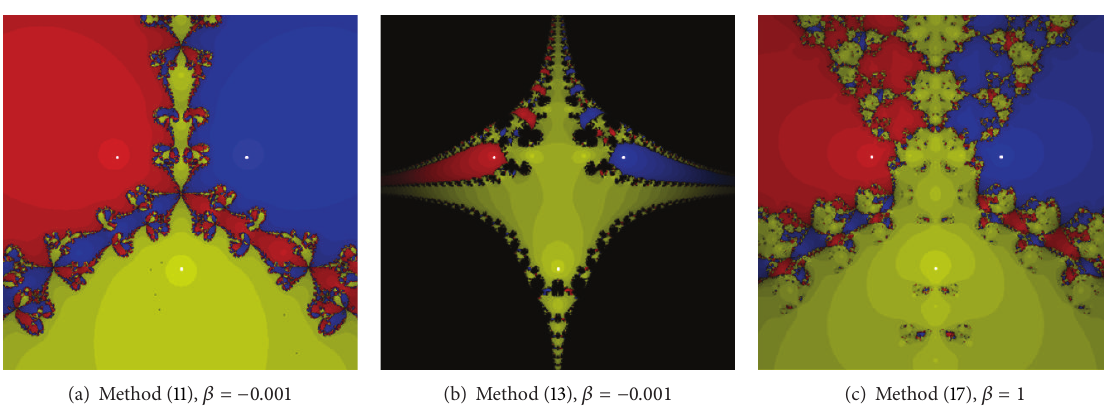
Figure 26: Basins of attraction of (11), (13), and (15) for the test problem 5.